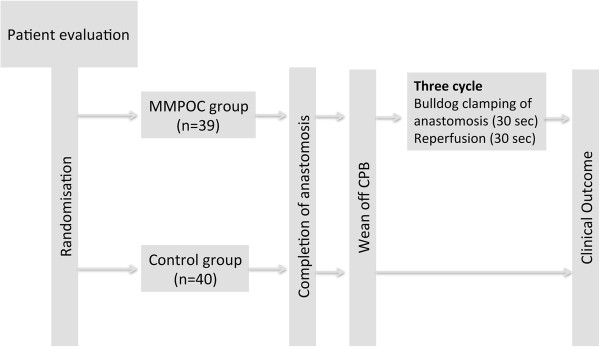
The Modified Mechanical Postconditioning (MMPOC) Protocol. Patients were allocated to the MMPOC group (n = 39) or the Control group (n = 40) using a computer-generated randomization code. During MMPOC protocol, proximal bypass anastomosis were completed and after wean off CPB phase, three cycle of bulldog clamping of anastomosis for 30 seconds and anastomosis were reperfused for 30 seconds. Then, clinical outcomes of the patients were recorded.